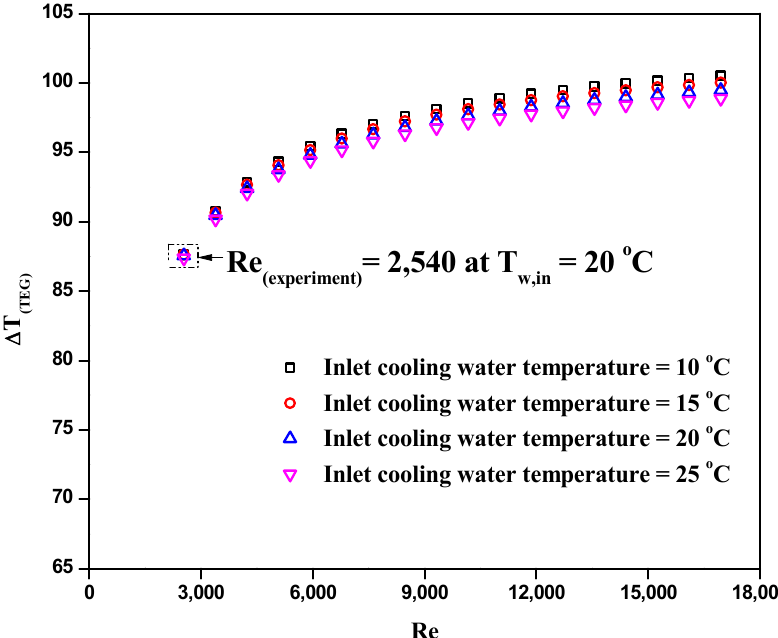
Figure 12. Variation in hot ‐ and cold ‐ side temperature difference.